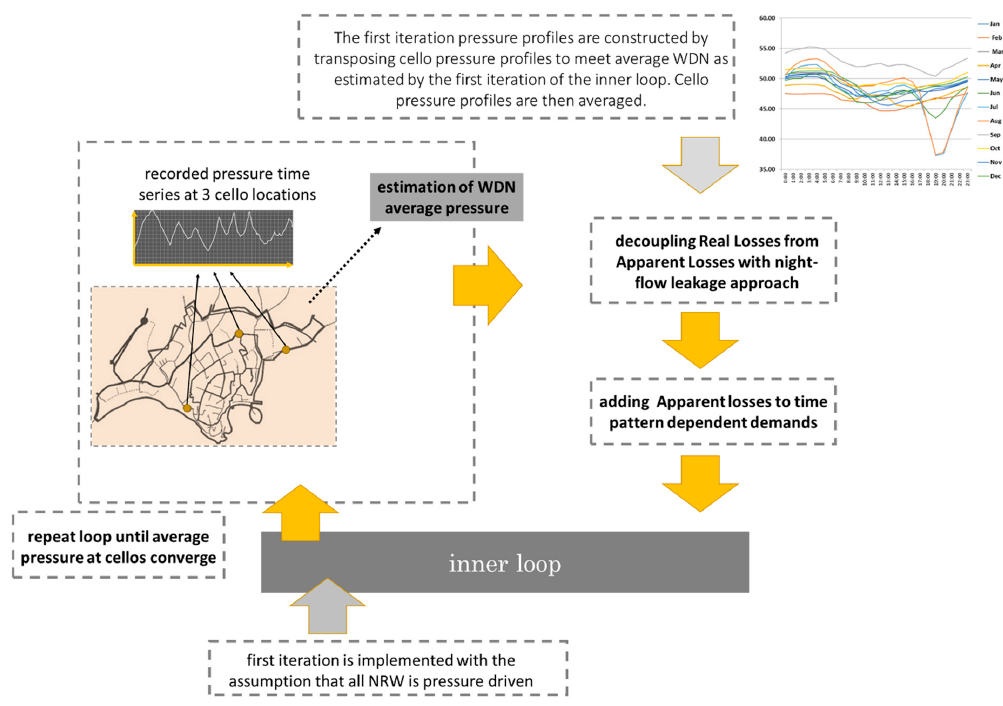
Figure 12. Outer loop for decoupling the real losses from apparent losses based on the night-flows leakage estimation methodology.